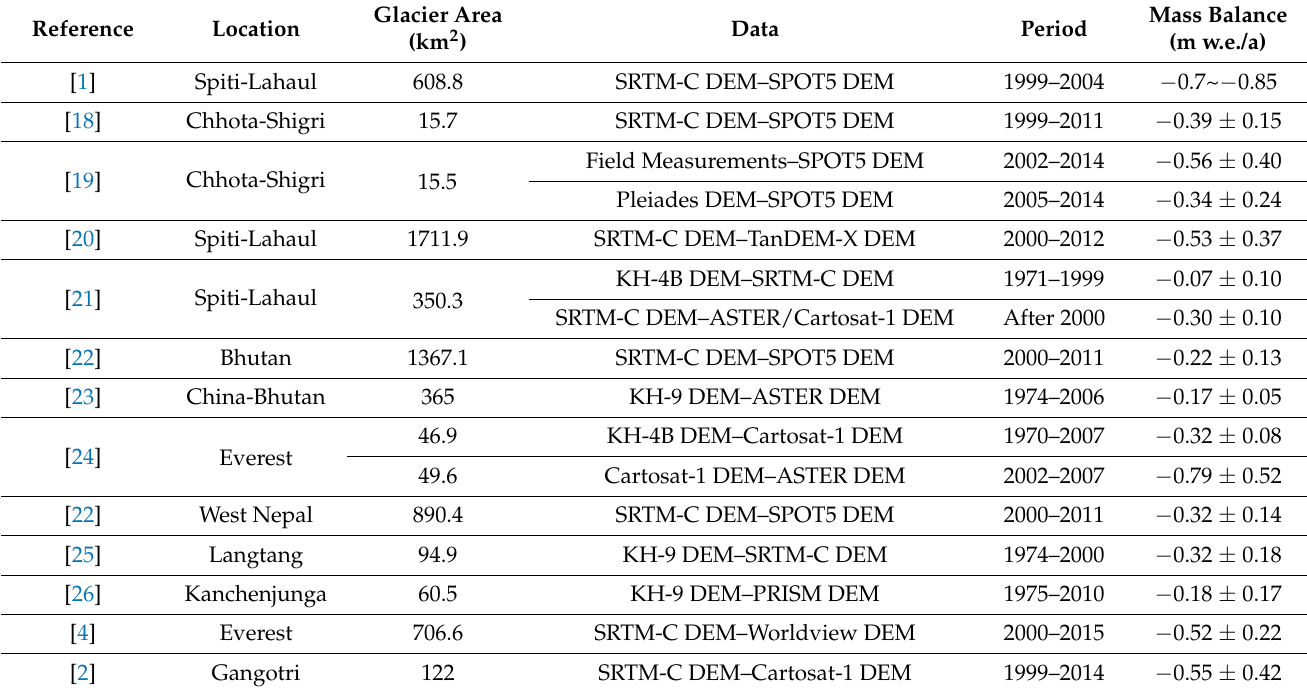
Table 1. Geodetic glacier mass balance measurements in the